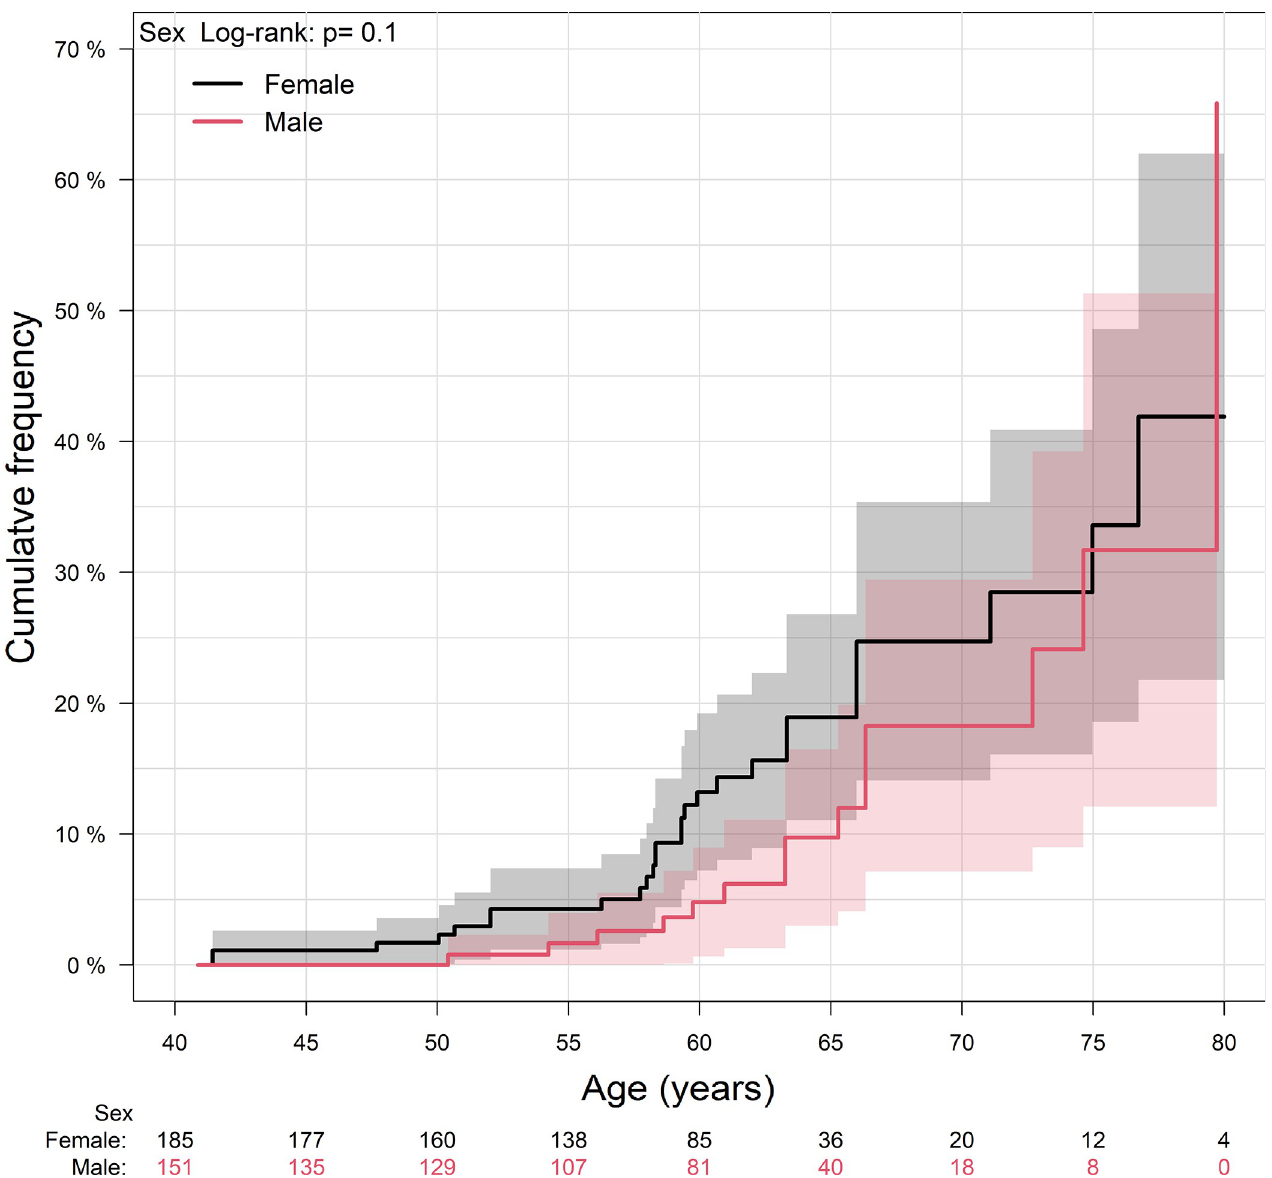
Fig 2. Cumulative frequency of numerous small hard macular drusen. Cumulative frequency of having � 20 small hard macular drusen per eye as a function of age and sex.